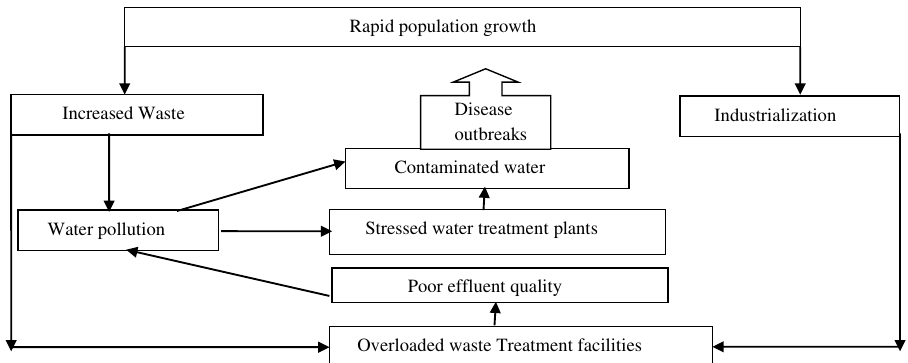
Rapid population growth